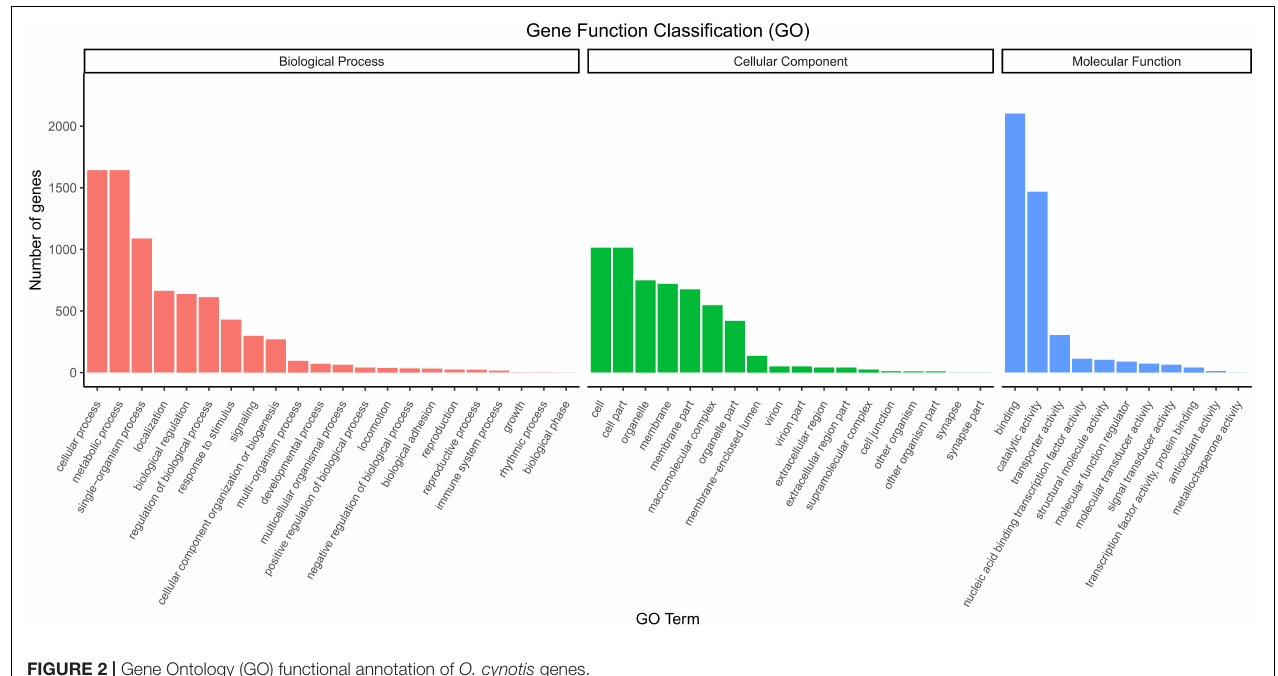
FIGURE 2 | Gene Ontology (GO) functional annotation of O. cynotis genes.